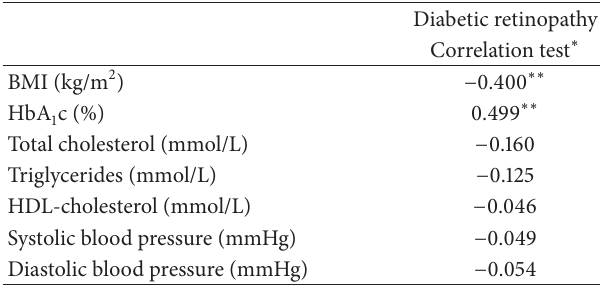
Table 9: Correlation between diabetic retinopathy and diabetes duration, body mass index, and metabolic and clinical parameters in type 1 diabetic patients with nephropathy ( 𝑛 = 52